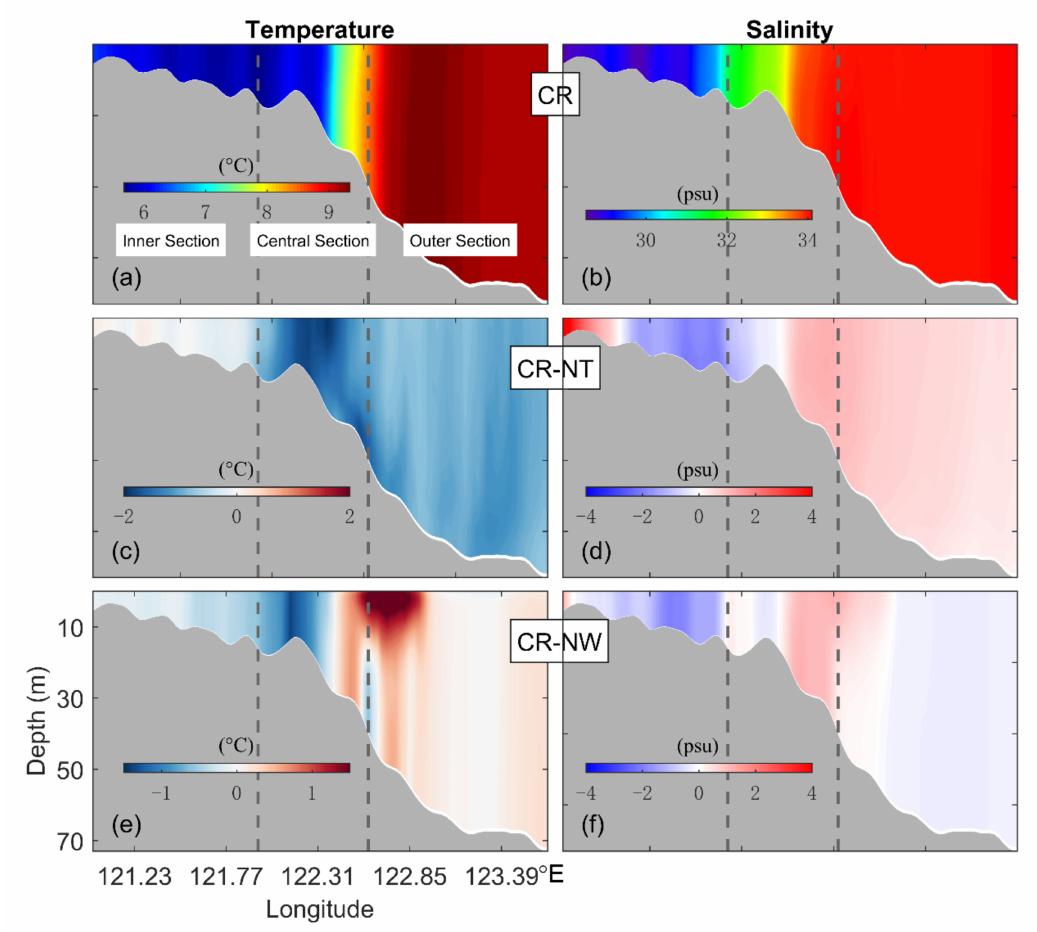
Figure 16. Vertical distribution of the simulated monthly mean temperature ( a ) and salinity ( b ) at transect HP (shown in Figure 5) based on the inner model results in the case of CR in February 2015, and differences in the simulated monthly mean temperature ( c , e ) and salinity ( d , f ) at transect HP between cases CR and NT and between cases CR and NW in February 2015,